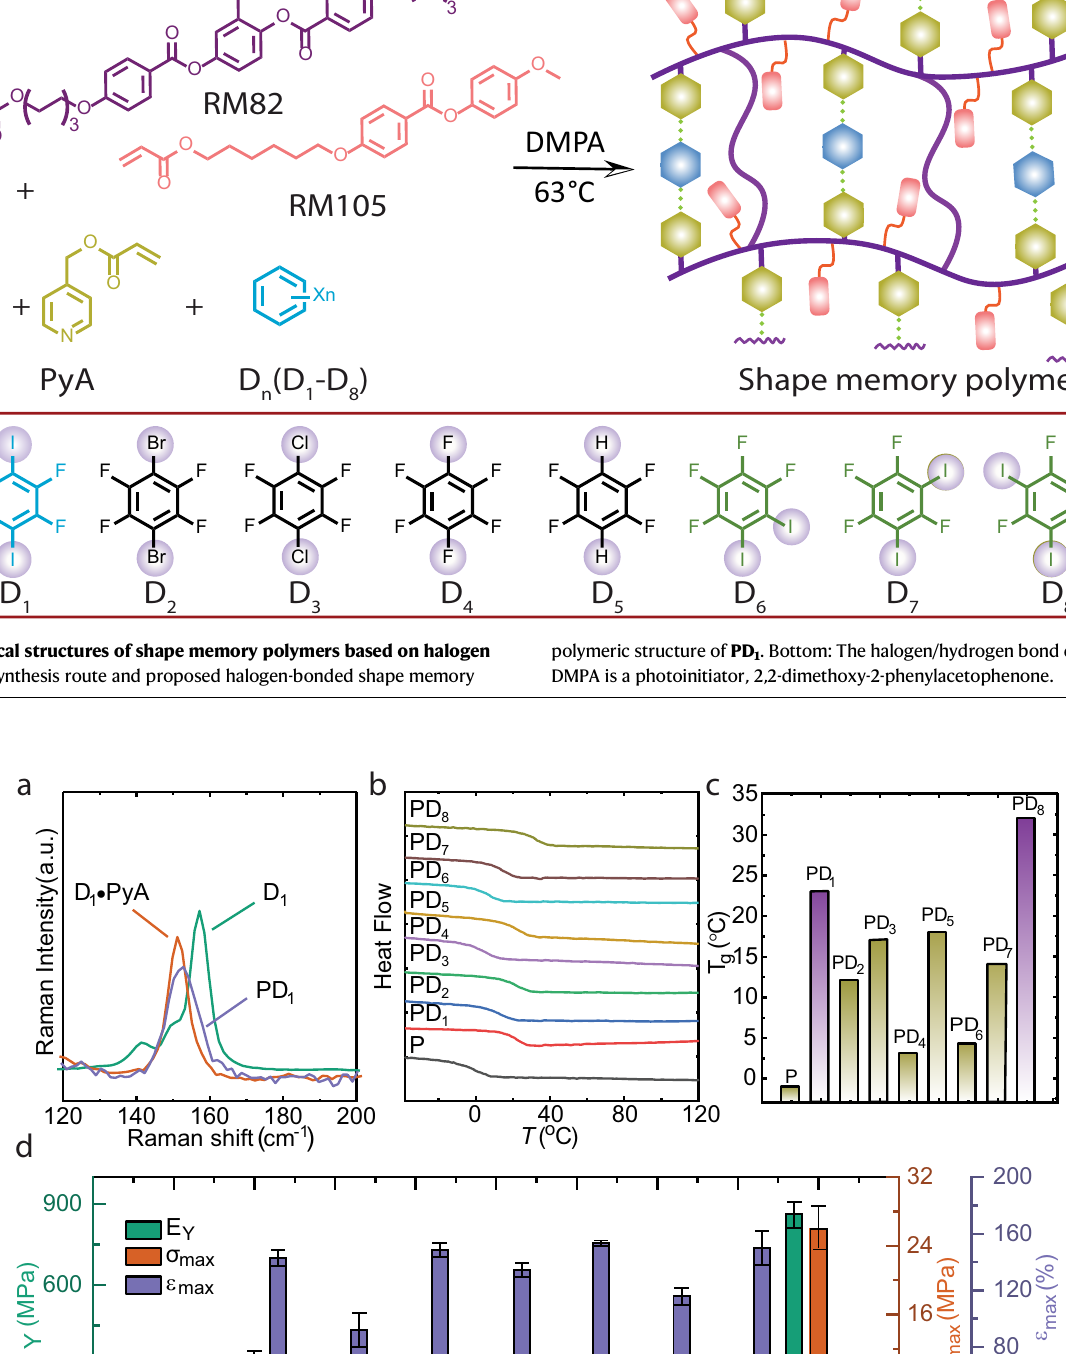
Fig. 3 | Characterization of the halogen-bonded polymer. a An overlay Raman spectrum of D 1 , D 1 ･ PyA , and PD 1 , indicating that halogen bonding results in C – I stretchingbandredshift. b DSCcurvesof P and PD 1 -PD 8 , c the T g of P and PD 1 -PD 8